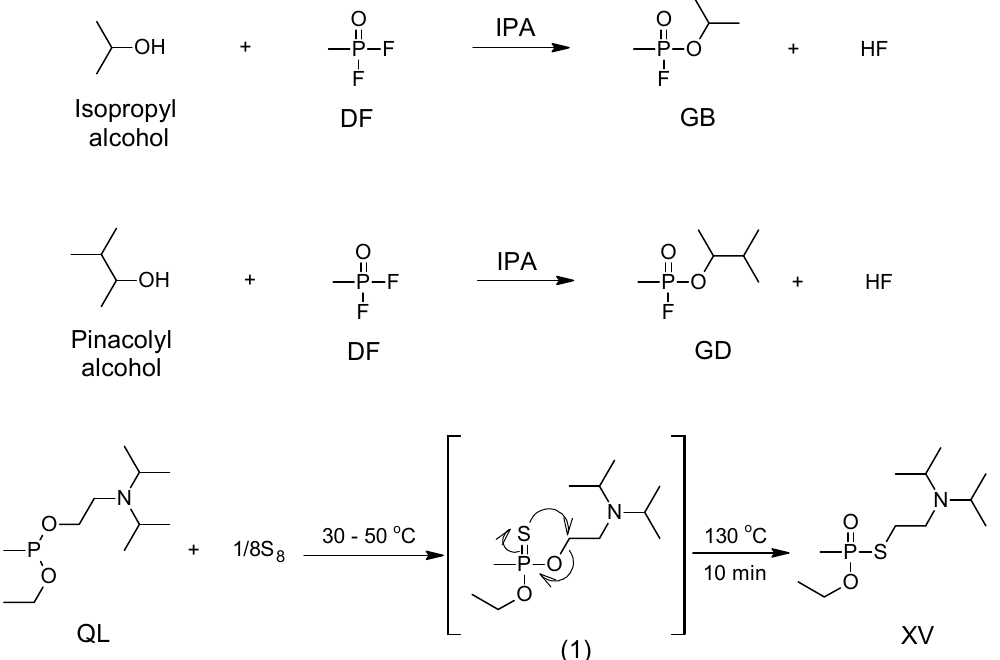
Scheme 1. Production reactions of sarin (GB), soman (GD), and XV in binary weapons [5–7].